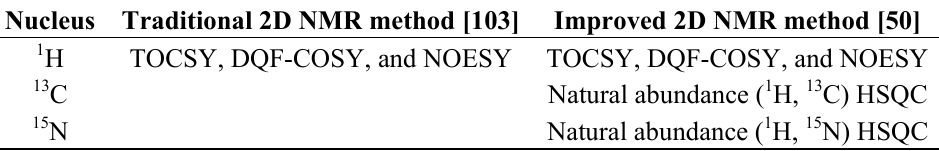
Table 4. Key experiments for traditional and improved 2D NMR